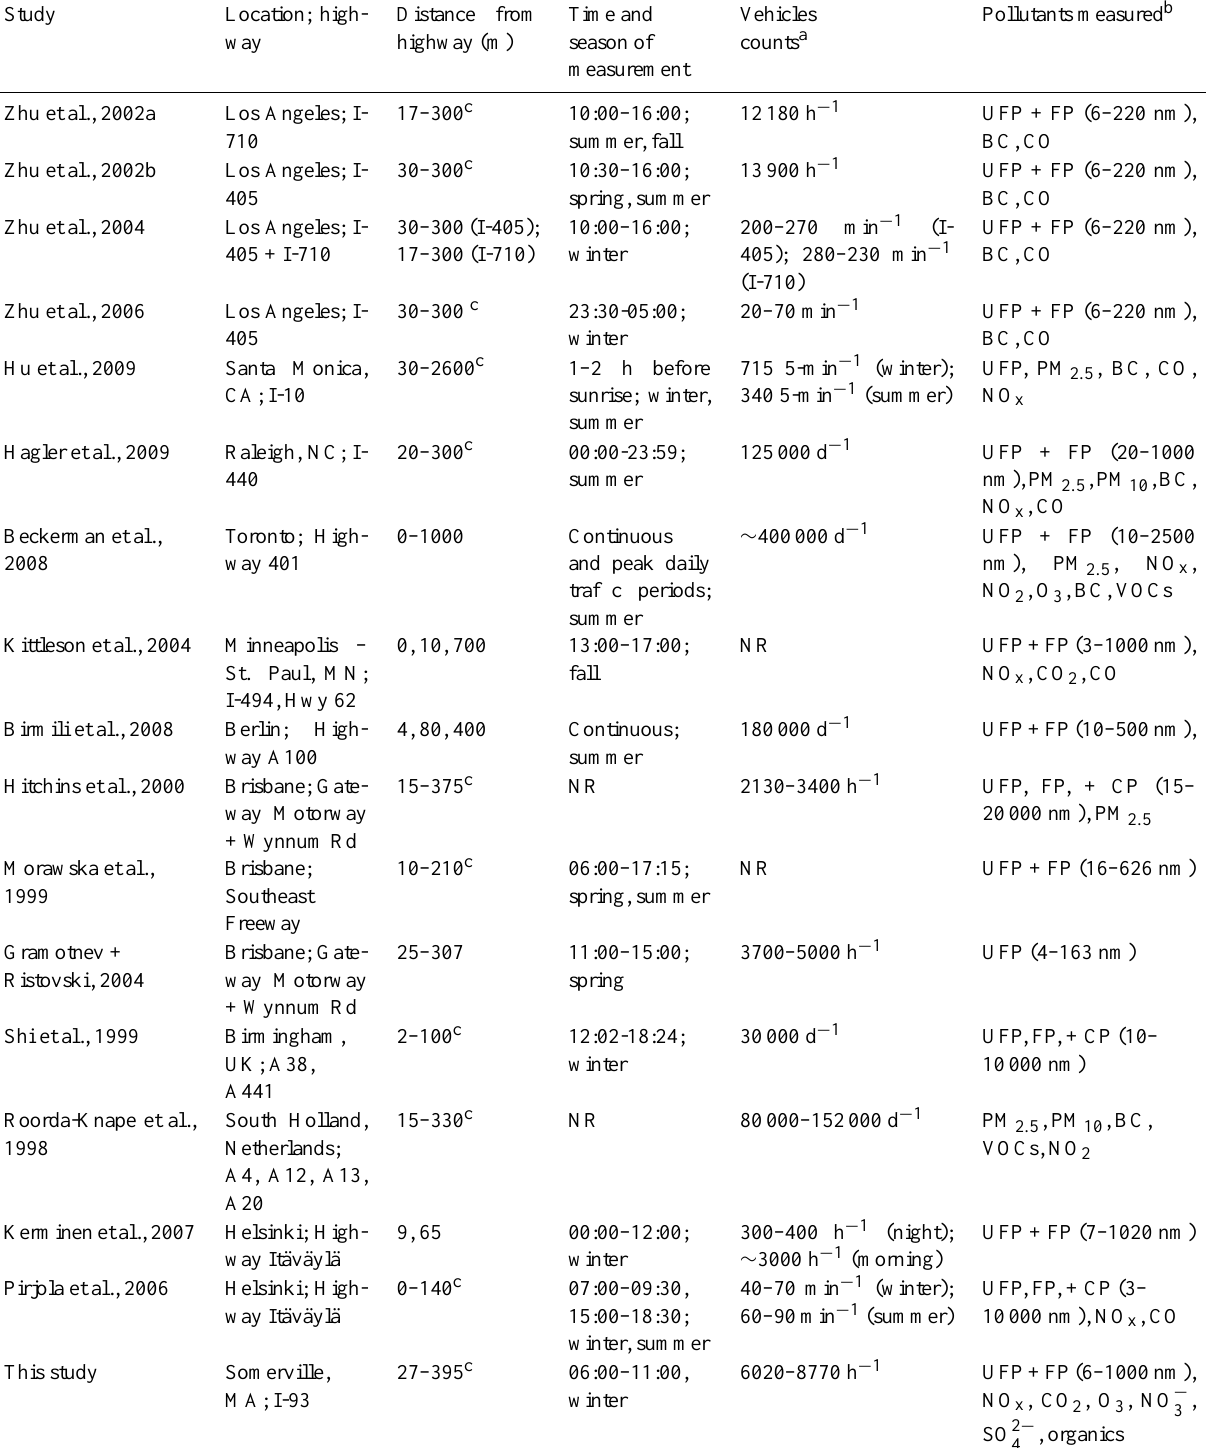
Table 1. Summary of near-highway air pollution monitoring